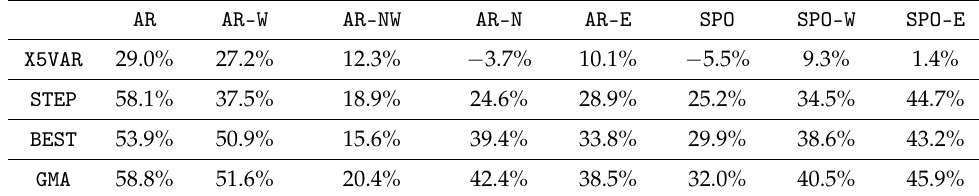
Table 5. Forecast skill score (SS) for the hindcast analysis under LOOCV . AR AR-W AR-NW AR-N AR-E SPO SPO-W